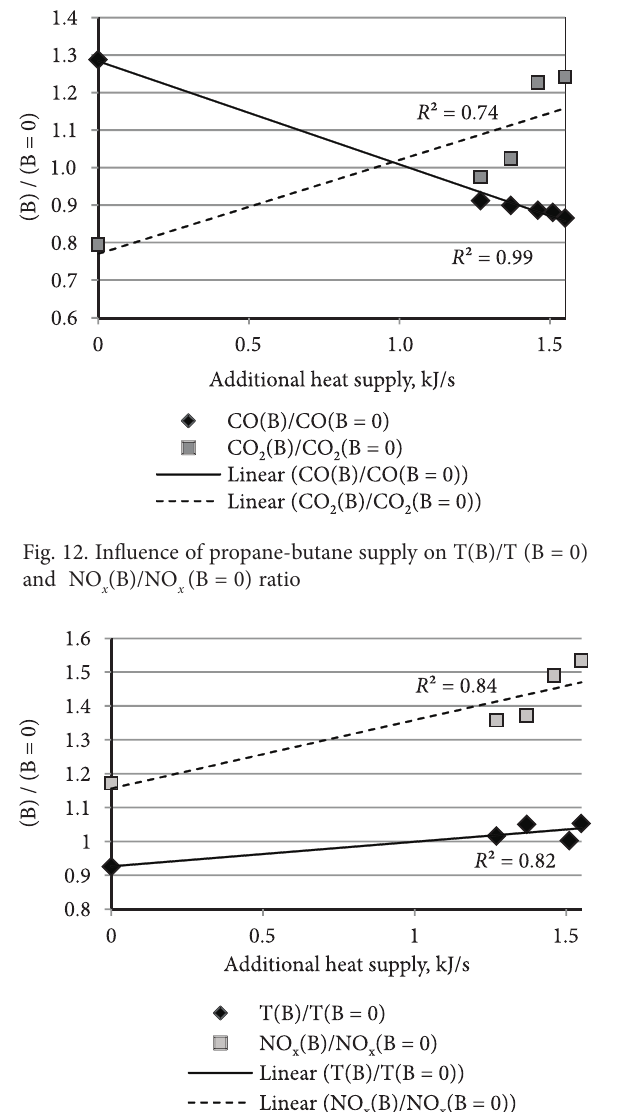
Fig. 13. Influence of propane-butane supply on Q(B)/Q(B = 0) and h (B)/ h (B = 0)